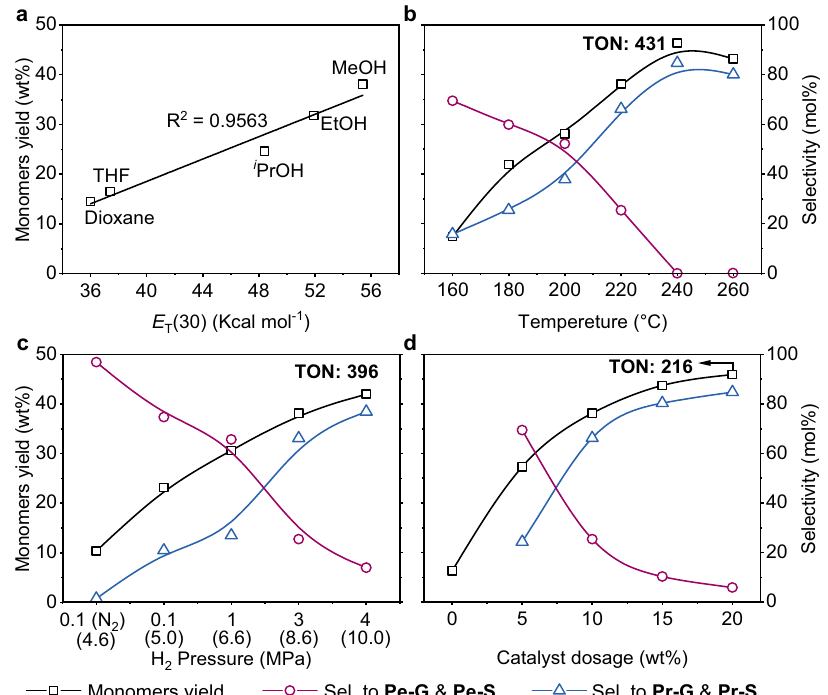
Fig. 4 | In fl uences of reaction parameters. a Solvent effect, conditions: birch wood (250mg), RuN/ZnO/C (10wt%), solvent (15mL), 220 °C, H 2 (3MPa at 25 °C, 8.6MPa at 220 °C), and 4h. b Reaction temperature effect, birch wood (250mg), RuN/ZnO/C (25mg, 10wt%), MeOH (15mL), 160 – 260°C, H 2 (3MPa at 25 °C), and 4h. c H 2 pressure effect, birch wood (250mg), RuN/ZnO/C (25mg, 10wt%), MeOH